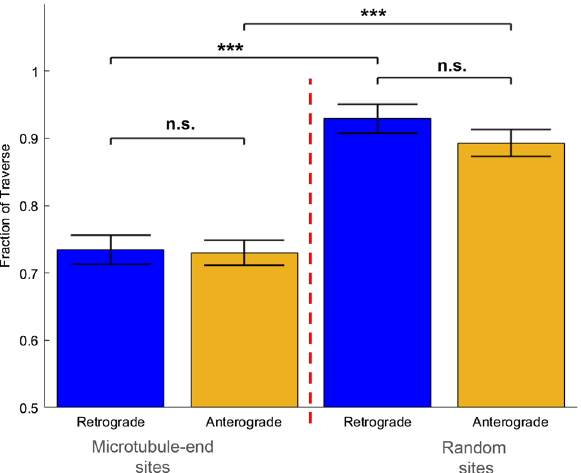
Figure 2. Probability Vesicles Traverse A MT-end. Both retrograde (Blue Bars) and anterograde (Yellow Bars) driven vesicles traverse MT-ends for the majority fraction of attempts (> 0.7 for both). Retrograde and anterograde motion traverse a greater amount at randomly chosen axon locations, as compared to MT-end locations. *** = p < 0.01; Error-bars are determined by standard-deviations in fraction of observed traversals per location.